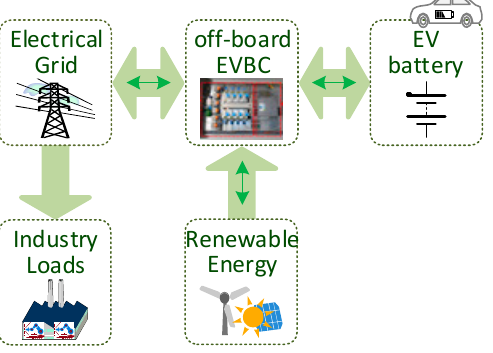
Figure 16. The principle of operation representative of the off-board EVBC operation as a power quality compensator.